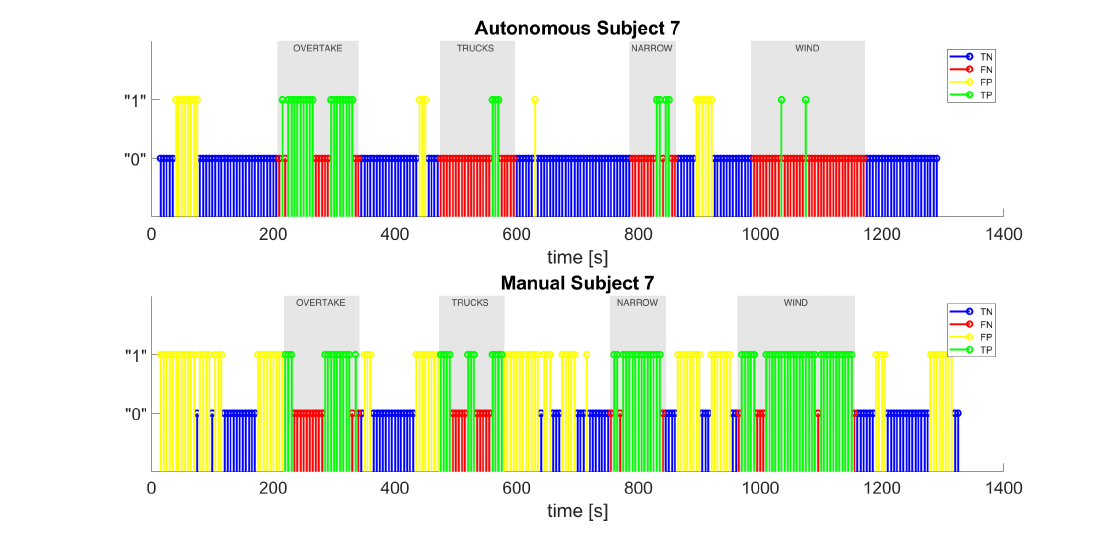
Figure 12. The classifier’s output for test subject 7 in autonomous and manual driving.